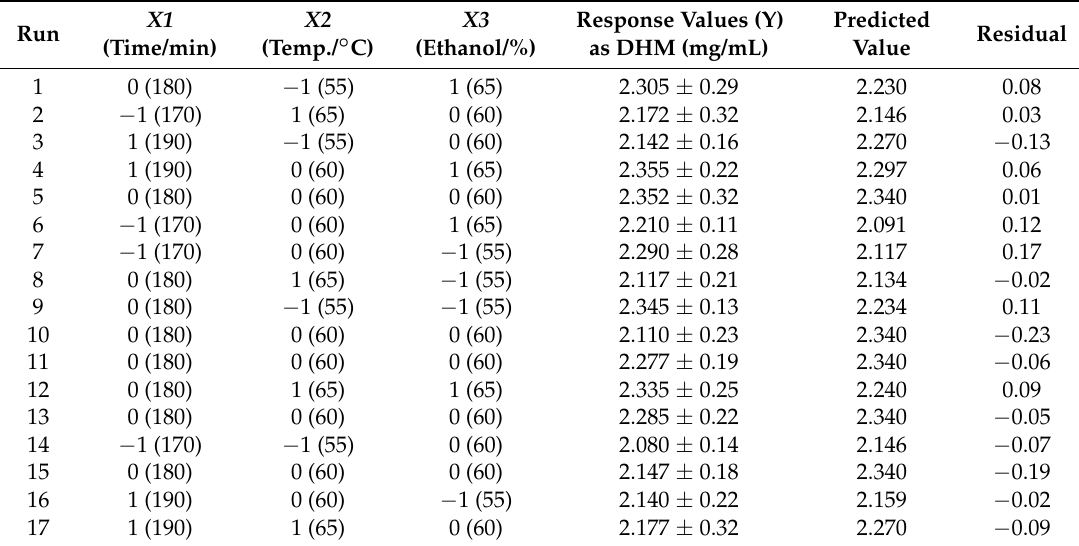
Table 2. The predicted values of Box-Behnken Design (BBD) alongside the obtained responses expressed as the actual concentrations of DHM (mg/mL).